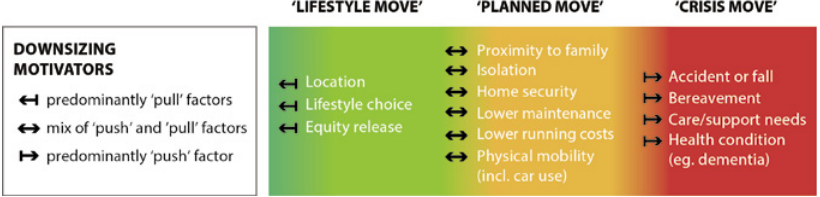
Figure 1. Typical “push” and “pull” factors affecting the decision to downsize. Image: